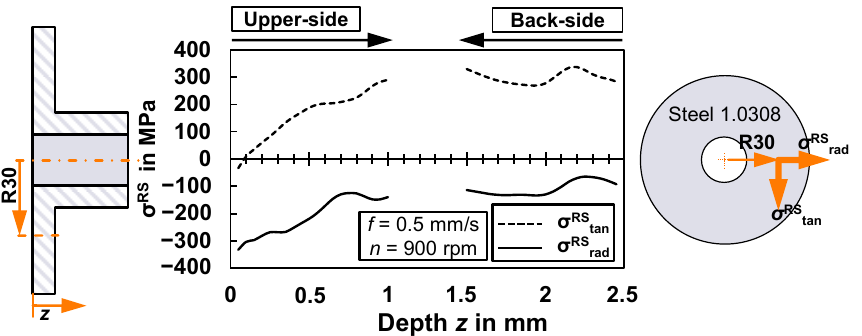
Figure 6. Continuous residual stress depth distribution. Flange formed by the friction spinning of steel tubes (1.0308). Process parameters: feed rate f = 0.5 mm/s, rotation speed n = 900 rpm, quenching v t performed with water after the process (at T max = 400 °C).